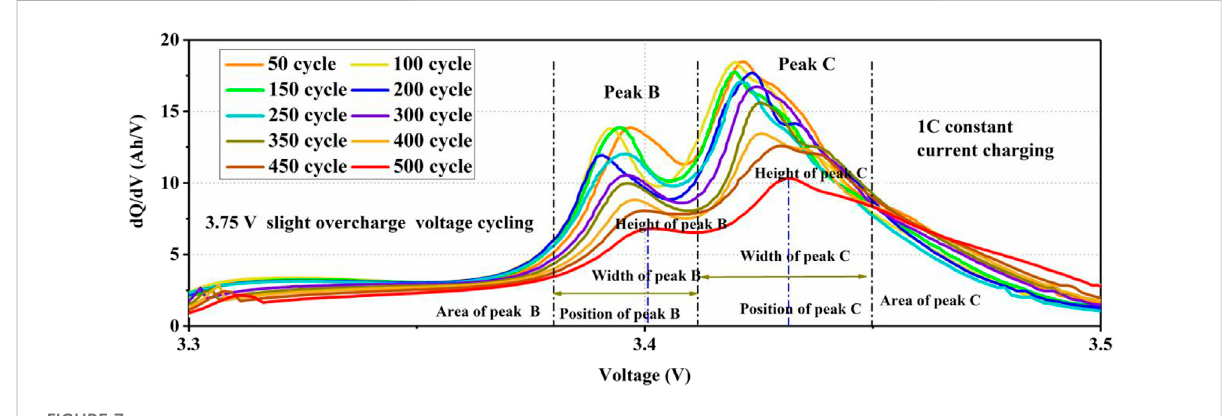
FIGURE 7 Extraction health indicators based on IC curves.